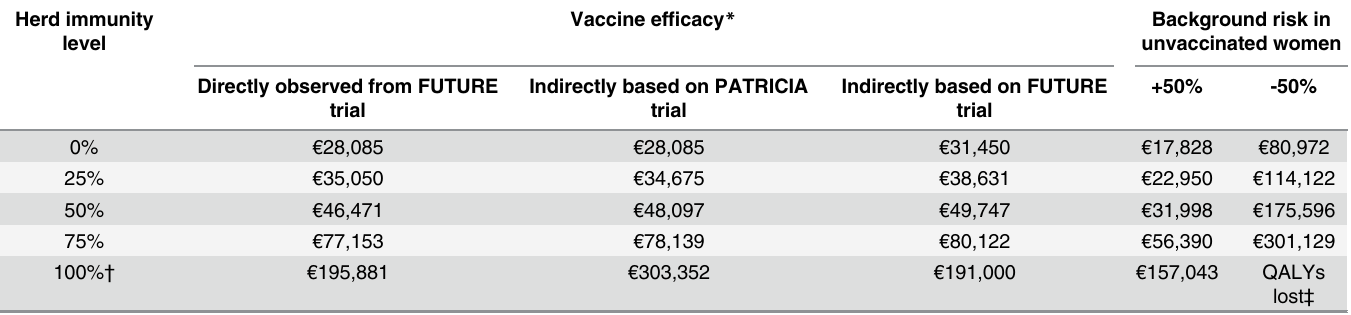
Table 4. Results sensitivity analyses: Incremental cost-effectiveness ratio of screening optimized to a pre-vaccination cohort, as compared to screening optimized to a vaccinated